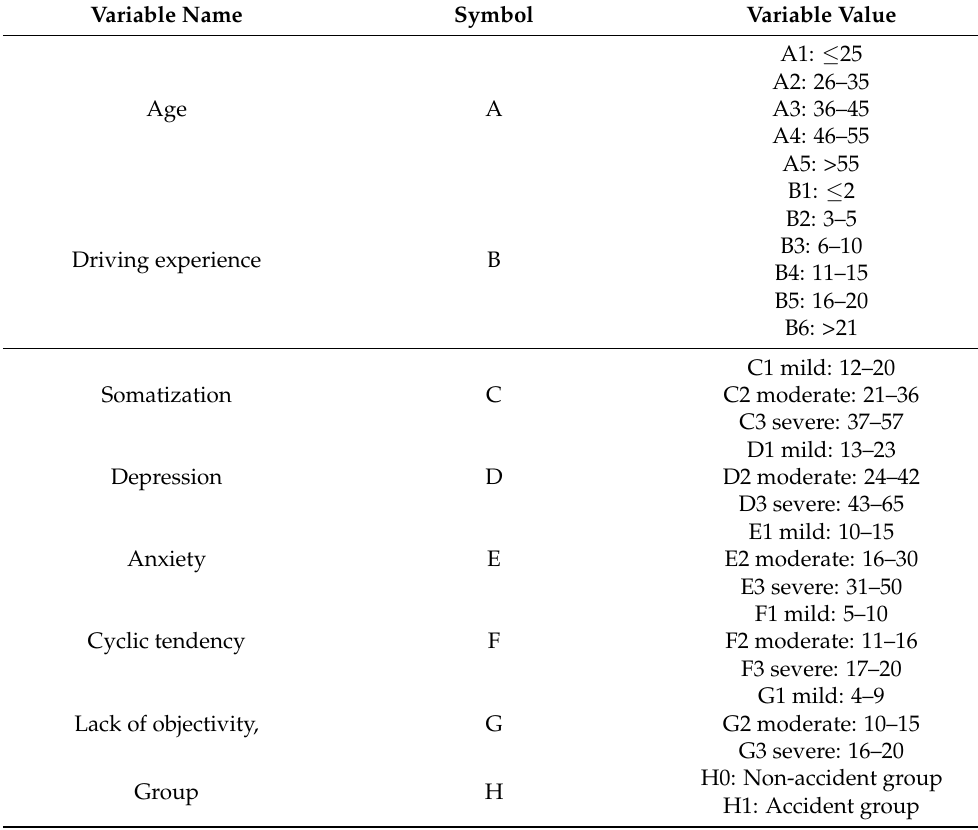
Table 3. Variables used to construct the Bayesian